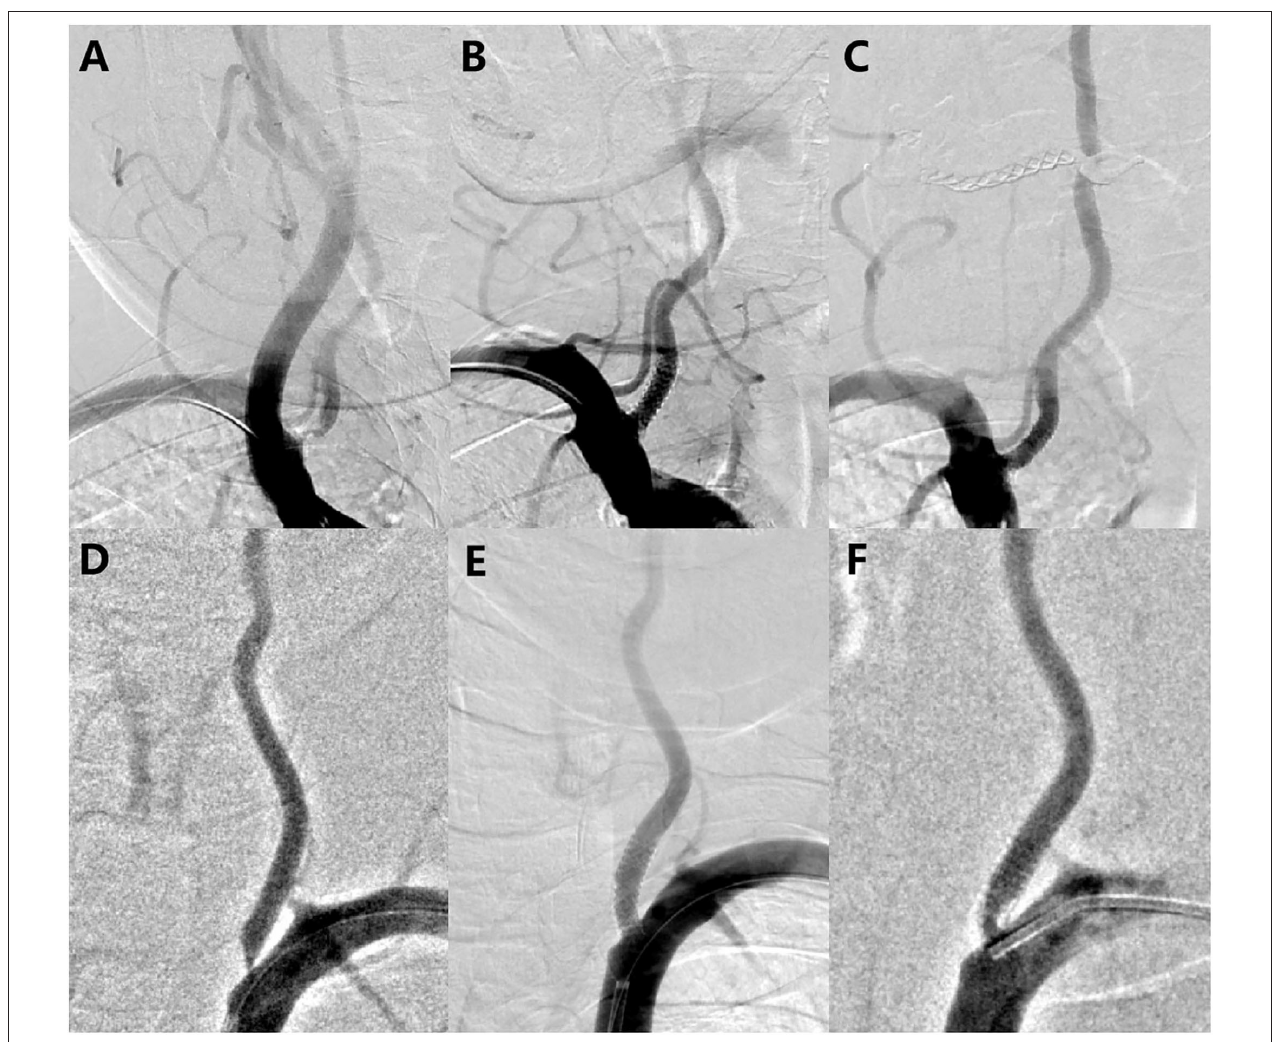
FIGURE 3 | Before and after treatment with the rapamycin-eluting stent. (A) Left vertebral artery high-grade stenosis before placing a long 16 × 4.0mm stent; (B) Immediately after implantation, demonstrating a wide-open arterial lumen with 4.5% residual stenosis; (C) 6-month follow-up angiogram showing approximately